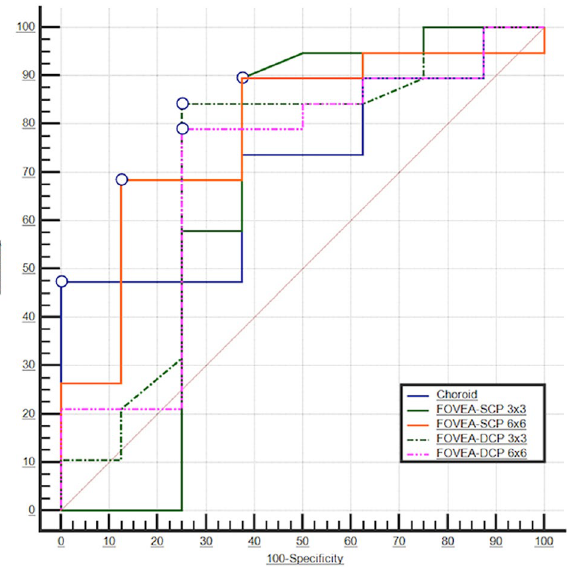
Figure 4. Areas under the curve (AUCs) of OCT-A parameters to identify HD patients experiencing hypotensive episodes. White circles indicate optimal thresholds (Youden index) for each variable. Differences in AUCs were statistically not significant.